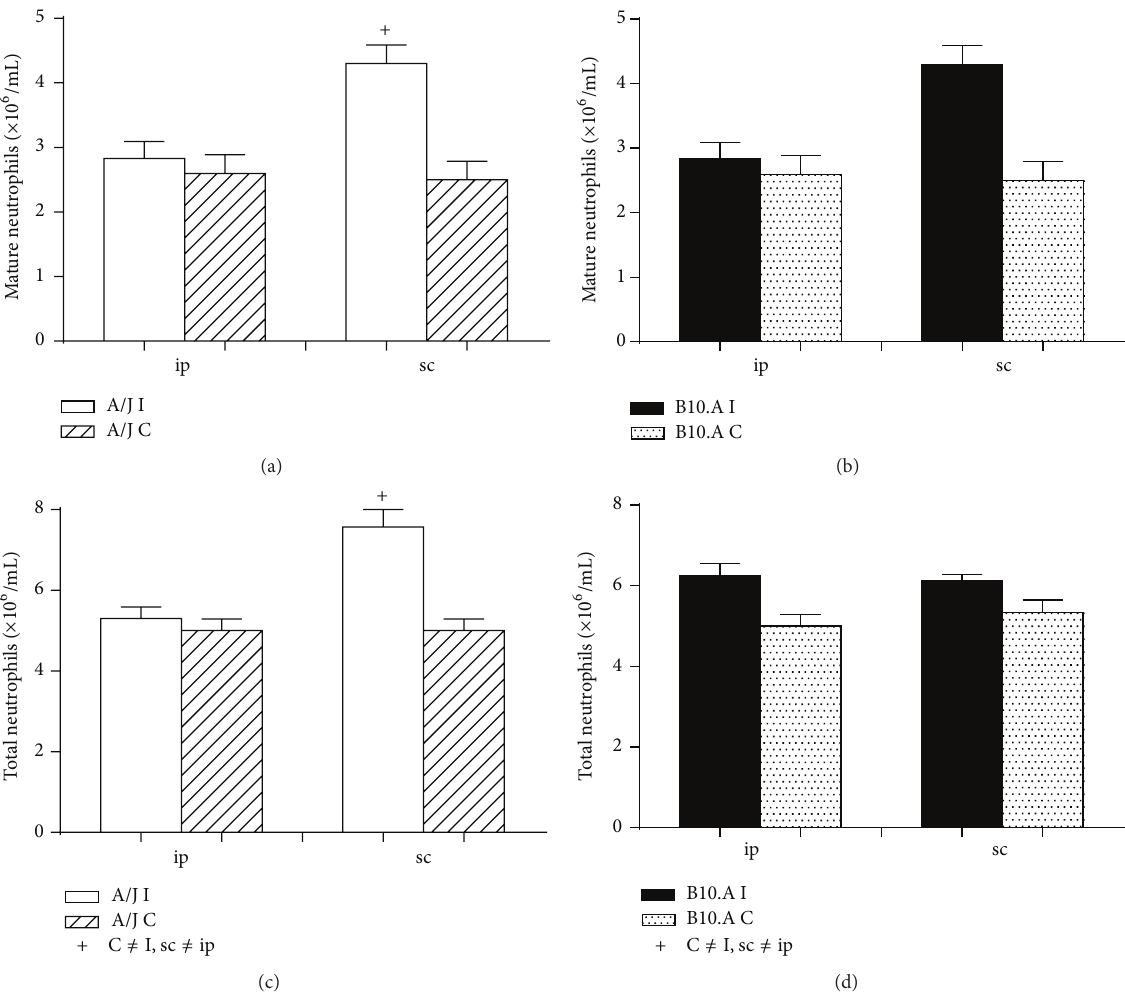
Figure 2: Relative neutrophilic population inside bone marrow between intraperitoneal and subcutaneous routes of Pb infection after 15 days: (a) mature cells in A/J resistant mice; (b) mature cells in B10.A susceptible mice; (c) total number of cells in resistant mice; (d) total number of cells in susceptible mice.